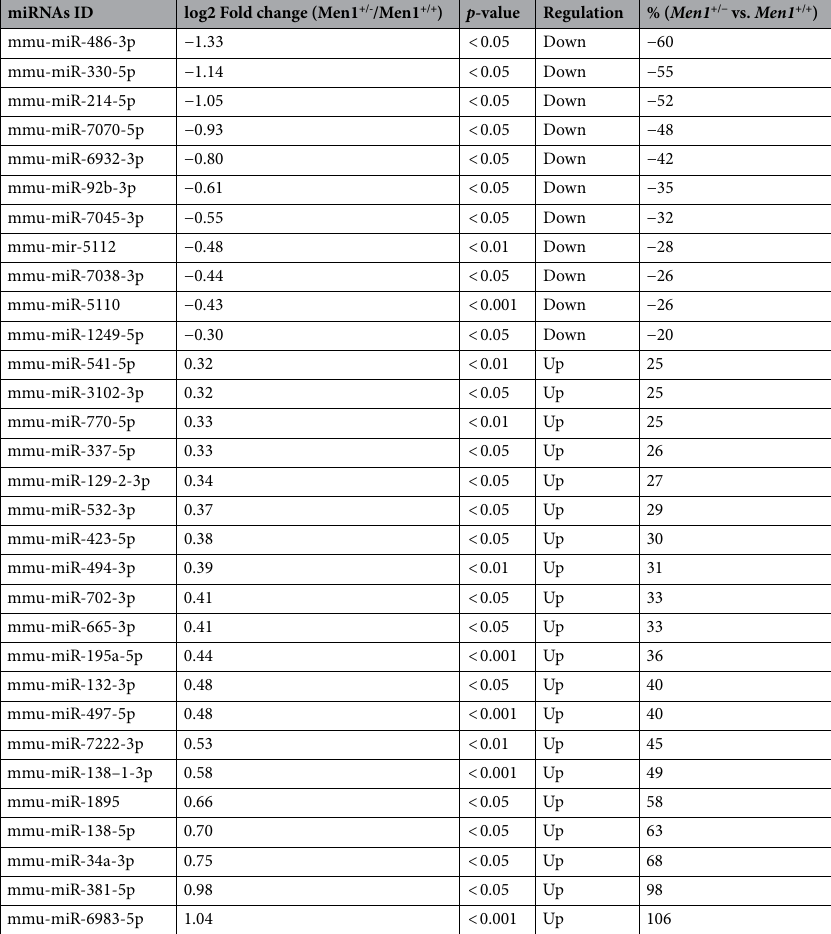
Table 1. Significantly differentially expressed miRNAs in adrenals of Men1 +/- compared to Men1 +/+ , ranked according to fold change.